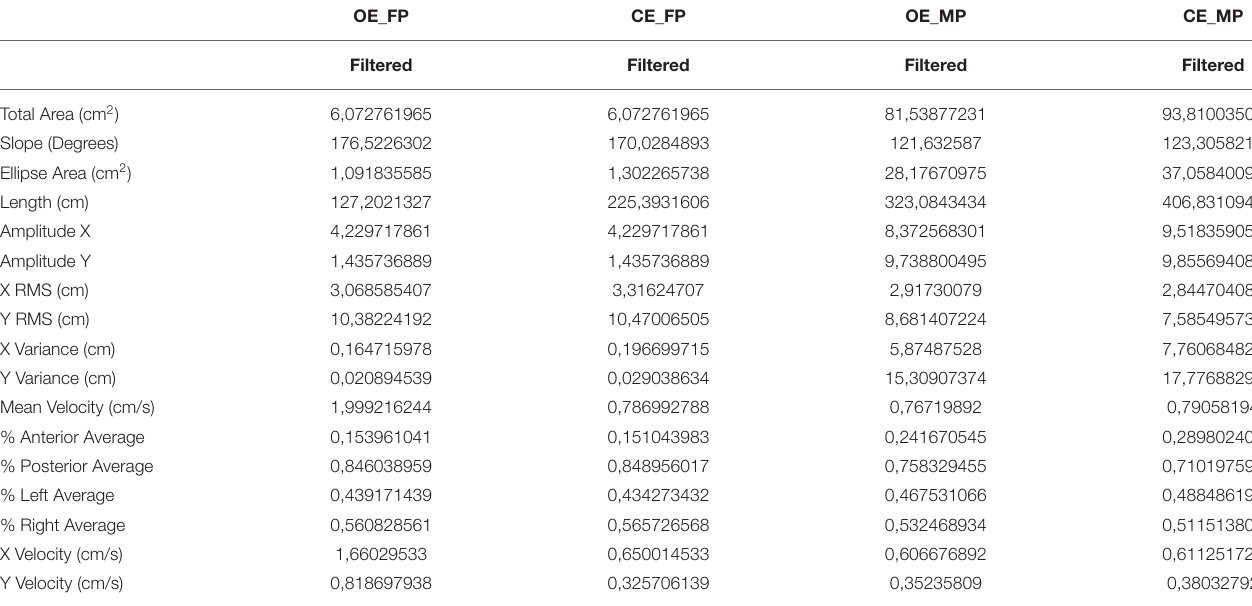
TABLE 3 | Values of the scores of the variables of the evaluation of the sensory organization test in posturography at the post-treatment or final moment.